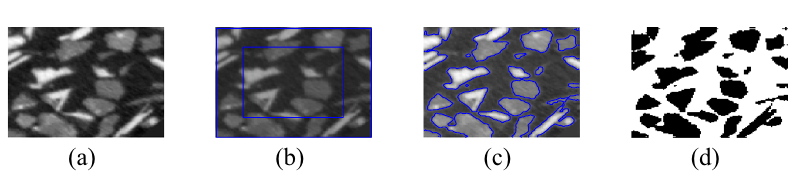
Figure 11. The segmentation results of the proposed model for the image taken from Furat et al. 40 : ( a ) 2D cut- out of tomographic image data of ore particles, ( b ) Initial contour, ( c ) Final contour and ( d ) Segmentated result of our proposed model with p = 0.6 , µ = 3, and σ =